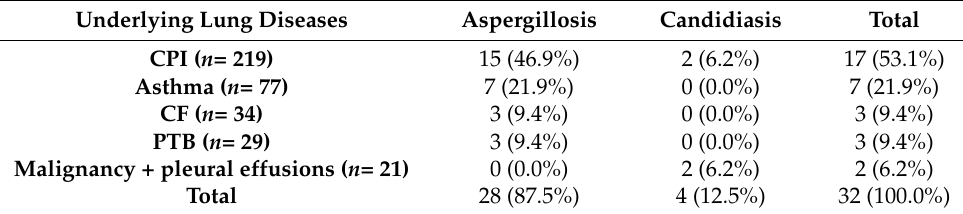
Table 2. Correlation between positive culture results and the underlying lung